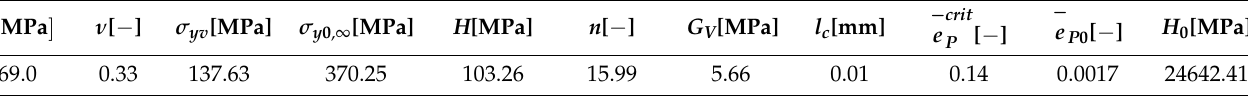
Table 2. Material parameters used in PFDM